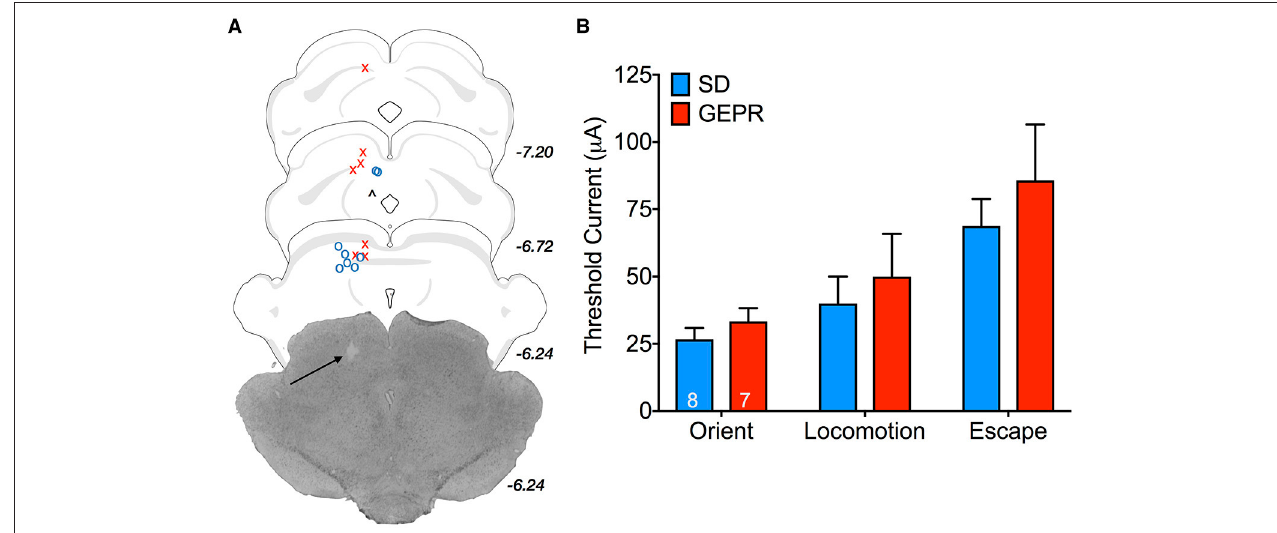
FIGURE 9 | Stimulation thresholds for DLSC-evoked behaviors in male rats. (A) Electrode placement; O = SD rats, X = GEPR-3s, ∧ = misplaced electrode. Black arrow points to electrode tip in the representative photomicrograph. Electrode tips are plotted on planes from the BrainMaps 4.0 Atlas ( 37). (B) Threshold current required to evoke orienting, locomotor responses, or escape behaviors. No differences between strain (Orient: t = 1.026, df = 10, P = 0.33 Locomotion: t = 0.488, df = 5, P = 0.65 Escape: t = 0.765, df = 13, P = 0.46). Figures show mean and standard error of the mean.